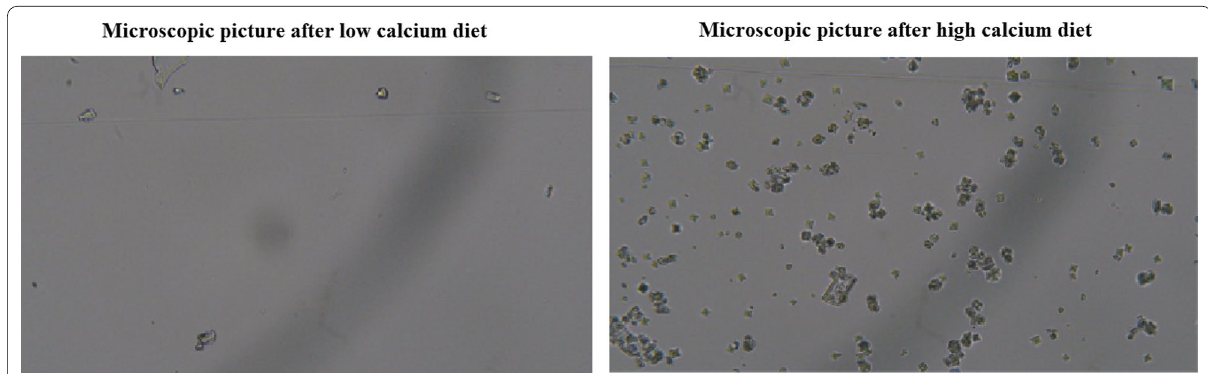
Fig. 2 Microscopic picture after low-calcium diet and high-calcium